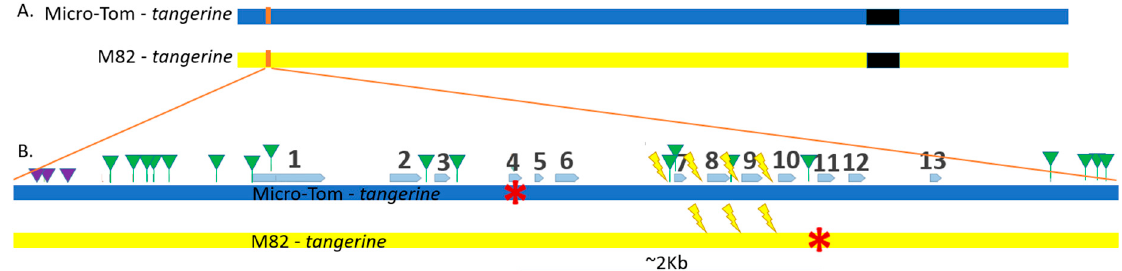
Figure 2. CRTISO gene map of targeted DSB IHSR assay. ( A ) Tomato Chromosome#10 scheme. The centromere is shown in black. The CRTISO gene is located at the sub-telomeric region of chromosome 10, on the reverse strand. Its approximate location is in orange. ( B ) The scheme of CRTISO gene region with exon 1 close to the telomere and exon 13 to the centromere. Exons are marked by blue arrows. Micro-Tom tangerine allele and its-A mutation at exon 4, and M82 allele G to A mutation at exon 11 are marked by red asterisks. The distance between the mutations is ~2 kb. Indels are marked by purple triangles. Single nucleotide polymorphisms (SNPs) are marked by green triangles. Four gRNAs for DSBs (lightning bolts) in between the two mutations were designed to target introns, and named according to their location; for example, the target in intron between exon 8 and exon 9 was called target 8–9. Three targets can break both alleles. Target 6–7 is allele specific, targeting only the Micro-Tom allele due to a SNP resulting in an NGG forming a protospacer adjacent motif (PAM).